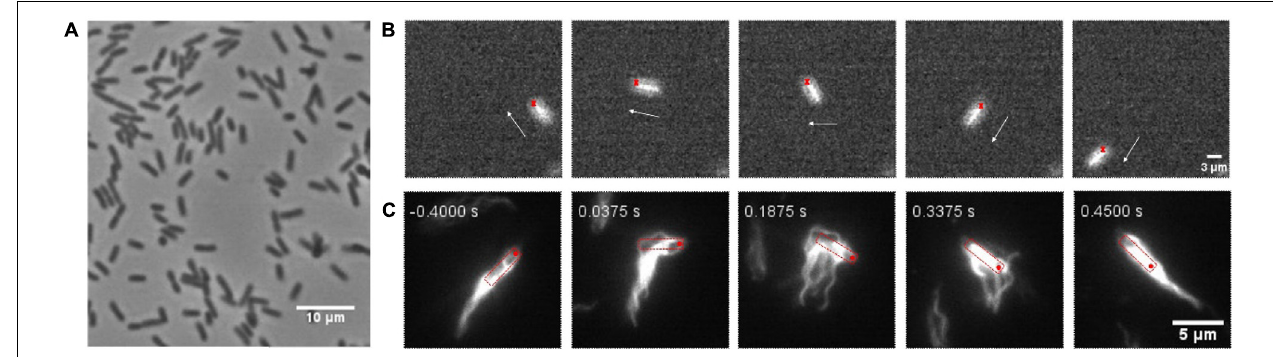
FIGURE 5 | (A) Bright-field image of cells in a quasi-two-dimensional water layer. (B) A typical cell reversal in a quasi-two-dimensional environment for (cid:49) cheY cells grown in bulk TB solution. Image sequences were taken from Supplementary Movie S6 . The red cross represents the head at the beginning and the white arrow indicates the instantaneous velocity direction of the cell. (C) Flagellar dynamics of a cell (grown in bulk TB solution) undergoing reversal. Image sequences were taken from Supplementary Movie S7 . The cell body is indicated by a red dashed box, and the red circle marks the position of the initial head.